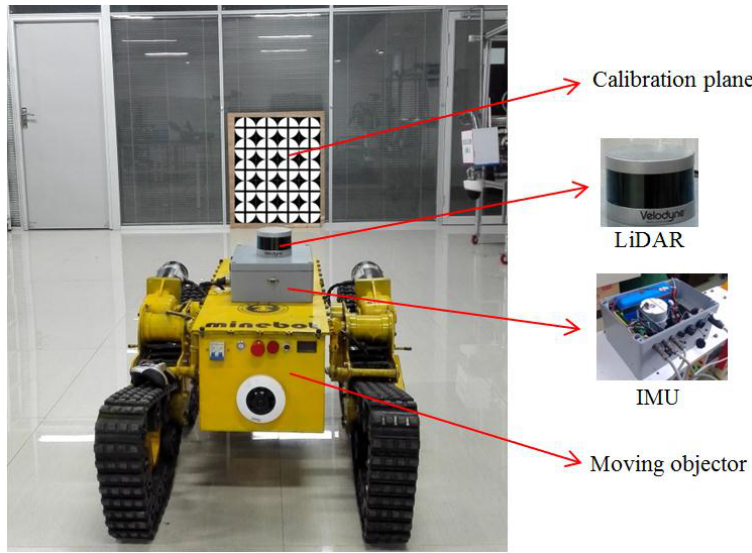
Figure 5. Experiment layouts. Table 1. The specifications of the IMU and LiDAR.